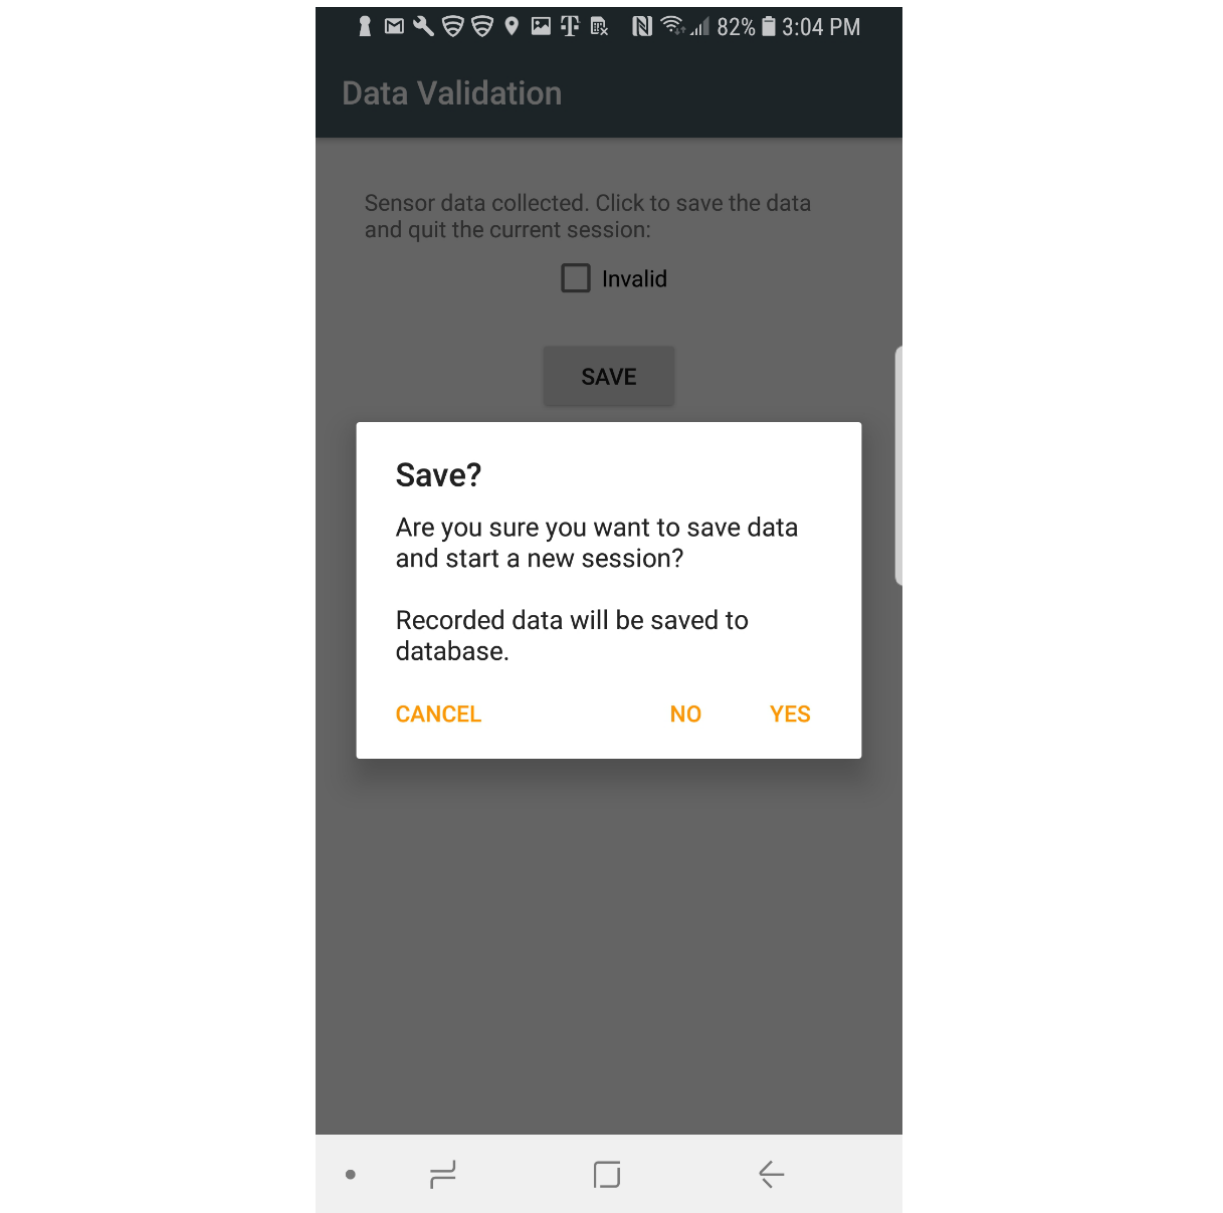
Figure 5. Confirm walk